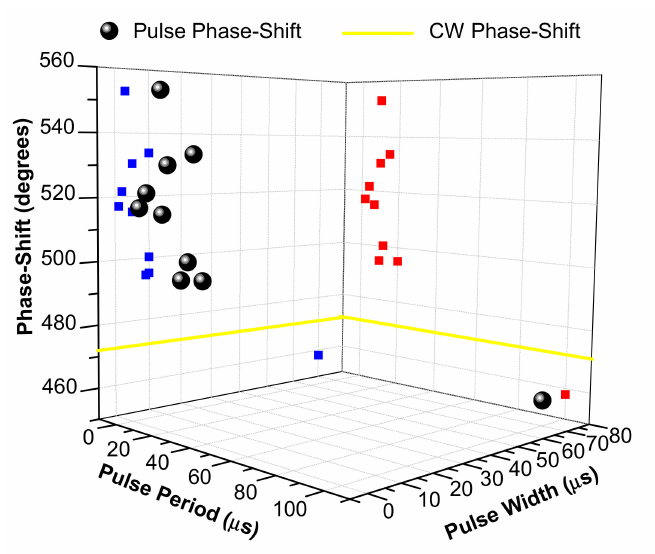
Figure 2. Polymer phase-shift after pulsed irradiation as a function of pulse period and pulse width ( • ), projection of the phase-shift in the pulse period axis ( (cid:4) ) and pulse-o ff time axis ( (cid:4) ). Polymer phase-shift after continuous irradiation